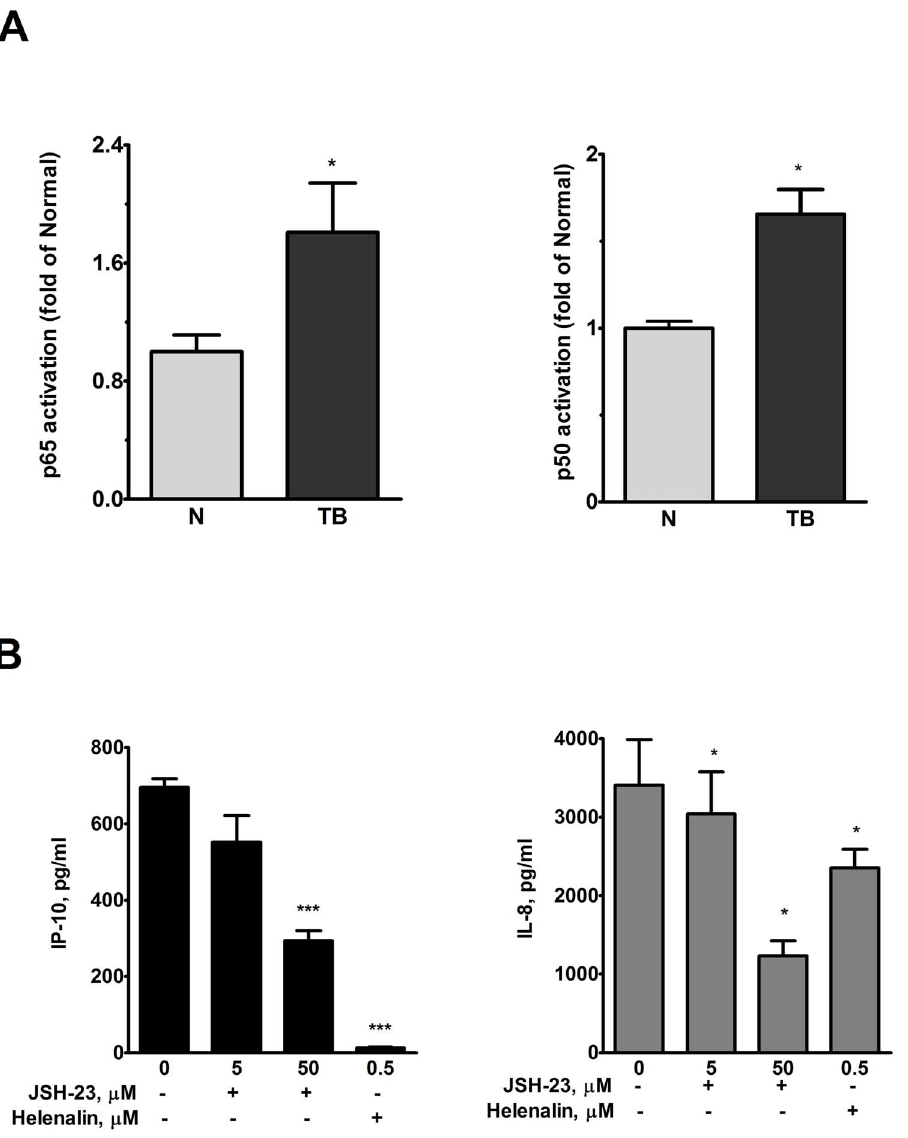
Figure 2. Increased NF- k B subunits, release of IP-10/CXCL10 and IL-8/CXCL8 in pulmonary TB. TransAM assay to measure the NF- k B subunit p65 and p50 activities reveals (A) an increase in basal state both p65 and p50 activities in PBMC of pulmonary TB patients (n=5) compared with those of normal subjects (n=4), * p , 0.05 compared with normal subjects; (B) the release of IP-10/CXCL10 (Left panel) and IL-8/CXCL8 (Right panel) from PBMC of TB patients (n=5) is significantly inhibited by NF- k B inhibitors either JSH-23 (5 and 50 m M) or Helenalin (0.5 m M) compared to those of the vehicle (0 m M). Data are means 6 S.E. *p , 0.05, ***p , 0.001 compared to the vehicle.